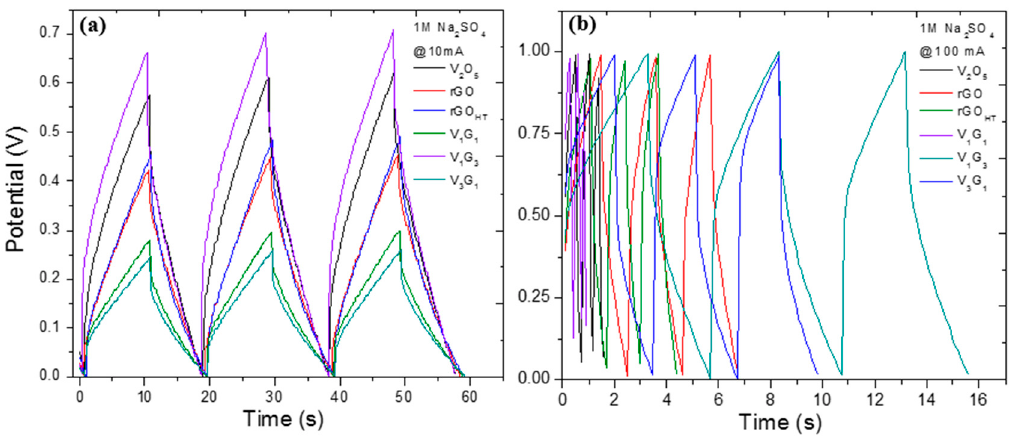
Figure 5. Galvanostatic charging-discharging profiles between 0.01 and 1.0 V at current densities of ( a ) 1 and ( b ) 10 A ∙ g − 1 showing characteristics discharging capacitor shapes.